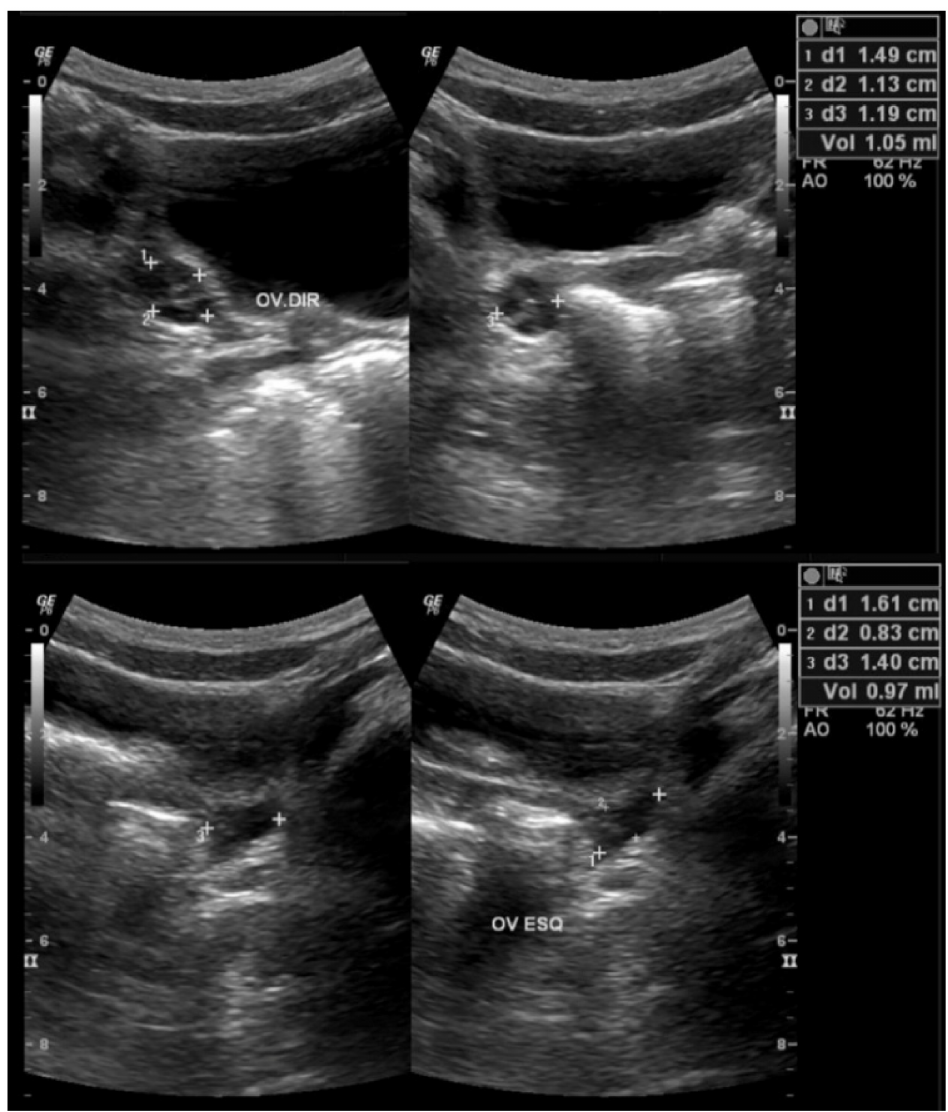
Figure 1. Ovarian ultrasound of a girl diagnosed with precocious puberty during the COVID-19 pandemic showing a reduced pubertal ovary. The patient started puberty at 7 years and 3